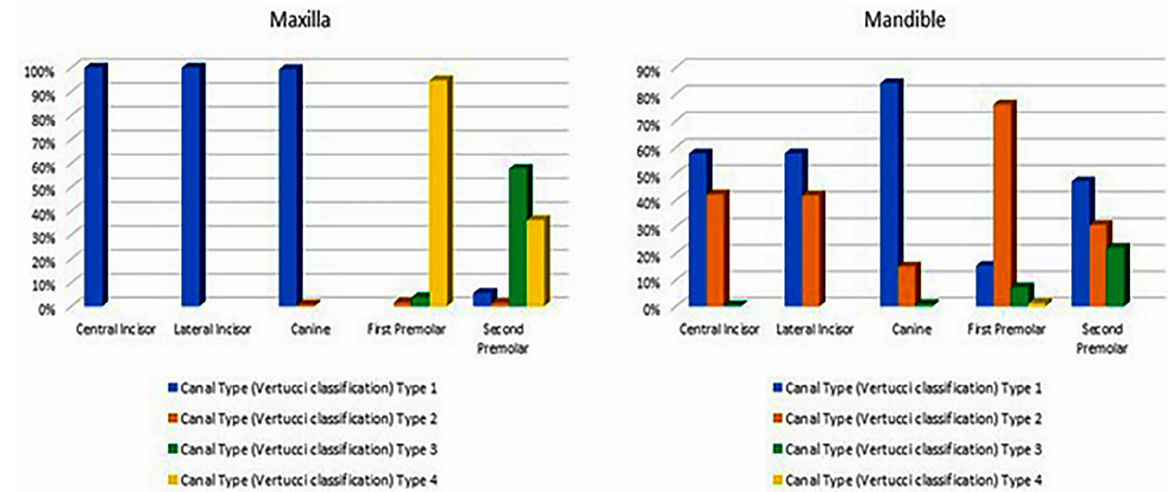
Figure 2- Frequency distribution of canal types in maxillary and mandibular